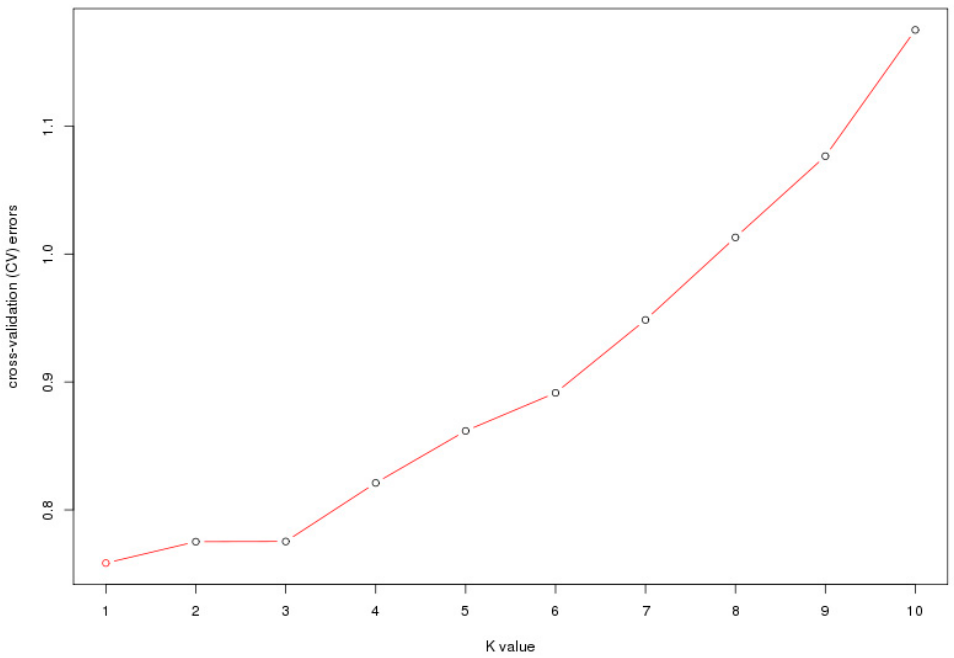
Figure 3. ADMIXTURE estimation of the number of groups for K values ranging from 1 to 10.